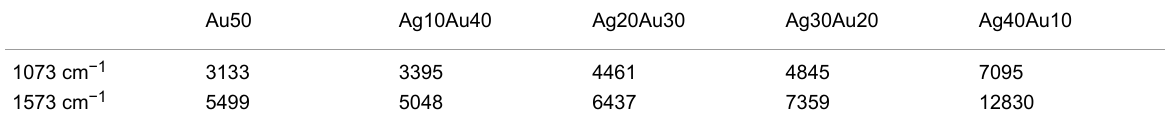
Table 2: Raman intensity (counts) at 1073 cm − 1 and 1573 cm − 1 for five different full-3D PCs with 580 nm